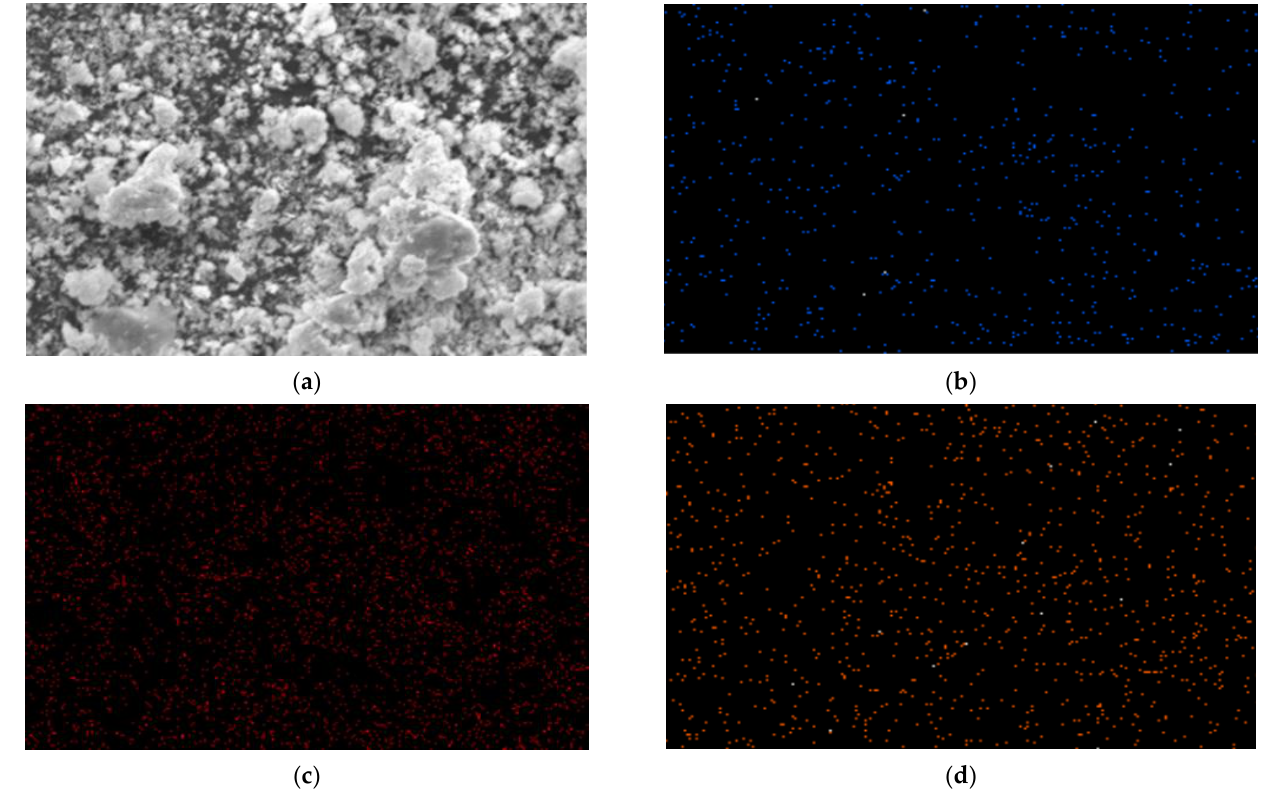
Figure 2. ( a ) EDX results for the BiOI nanosheets synthesized by sonochemical method at room temperature; ( b – d ) elemental mapping of oxygen, Iodide, and bismuth in the prepared BiOI.